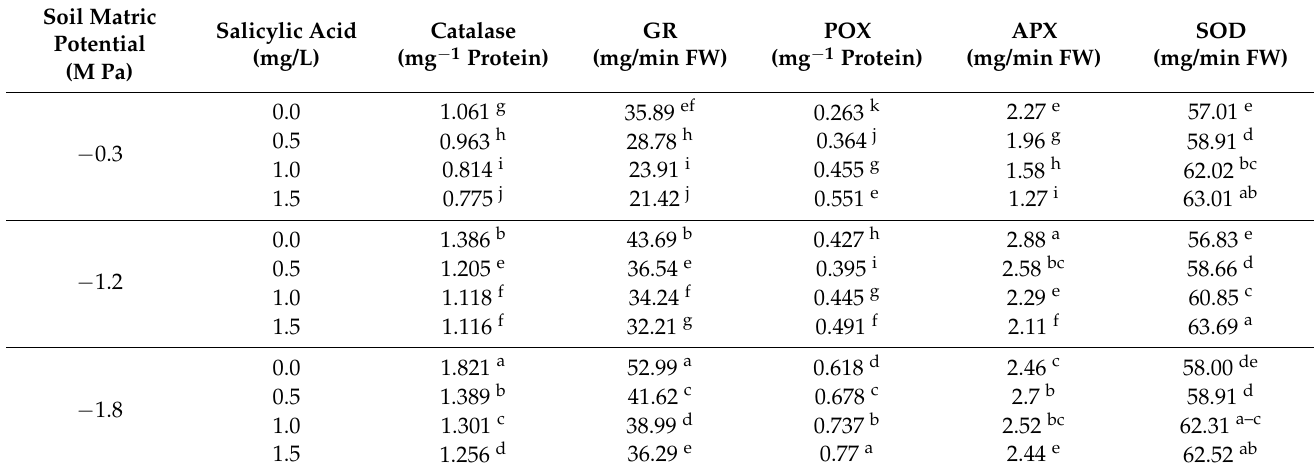
Table 4. Interaction effects of controlled water stress and foliar application of SA on antioxidants activity of pumpkin. (The matric potential (MPa) value was measured just before